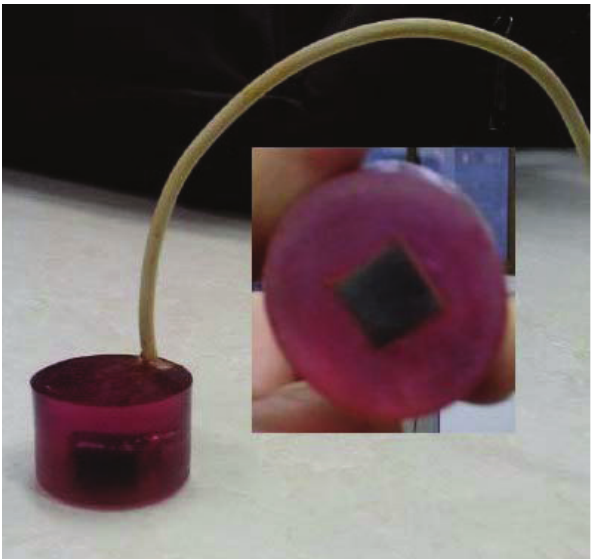
Figure 2: The steel embedded in the epoxy resin used for chronoamperometry